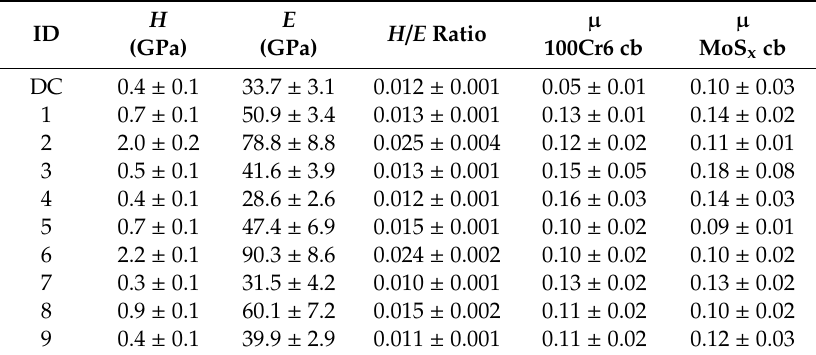
Table 3. Mechanical properties (hardness H and Young’s modulus E ) and friction coe ffi cient µ of the MoS x films using the uncoated or MoS x -coated 100Cr6 counter body